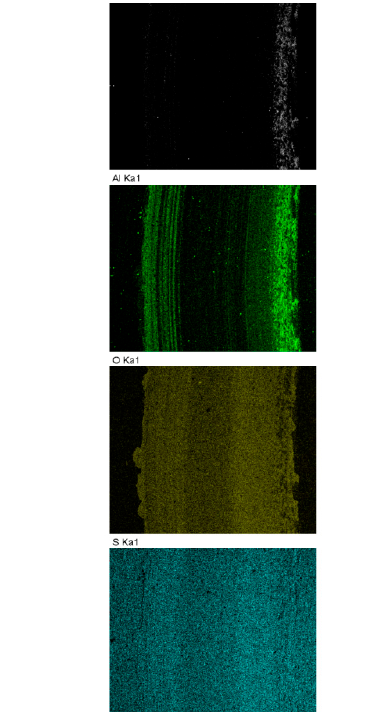
analysis) created after the tribological test using the pin-on-disc method on Vanadis 8 steel samples,